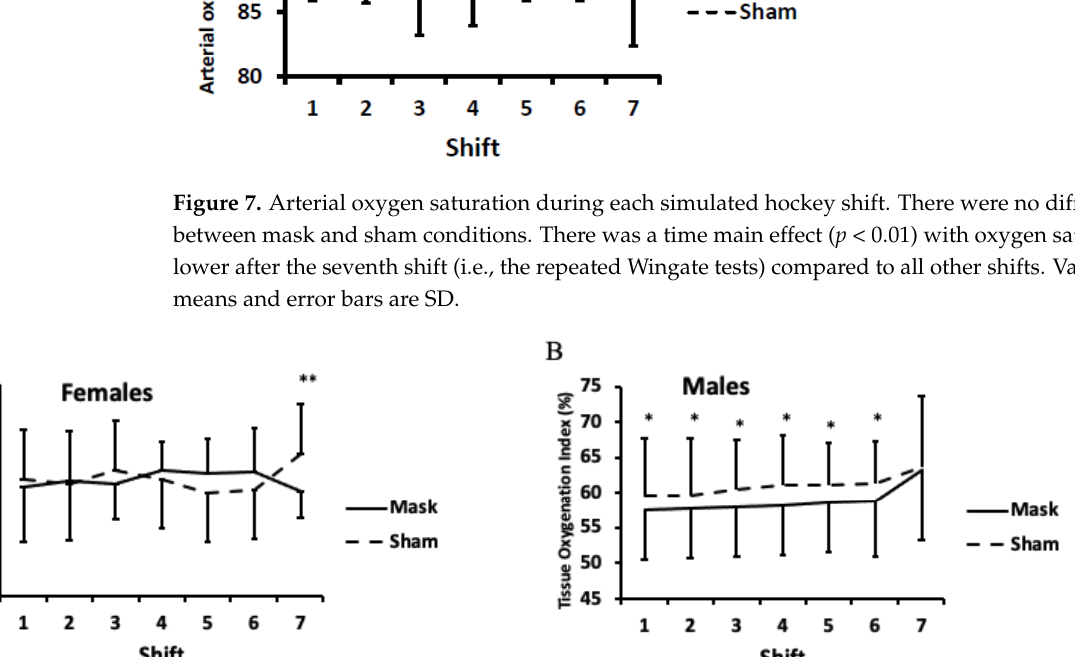
Figure 8. Tissue oxygenation index for females ( A ) and males ( B ). There was a sex × mask × time interaction ( p < 0.01). LSD post hoc testing: ** Tissue oxygenation index was lower during the mask compared to the sham condition after shift 7 for females ( p < 0.01). * Tissue oxygenation index was lower during the mask compared to the sham condition during shifts 1 – 6 for males ( p < 0.05). Values are means and error bars are SD.